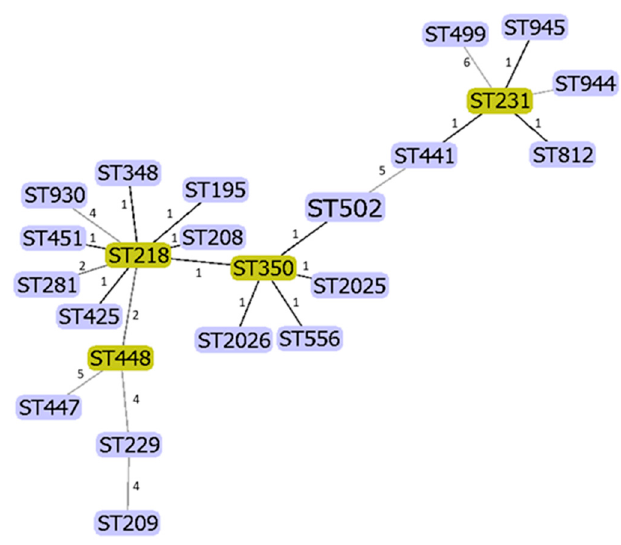
Figure 2. Dendrogram of detected MLSTs in A. baumannii in Austria. Dendrogram was calculated using goeBURST full MST algorithm using PHYLOViZ software (https://phyloviz.readthedocs.io/en/latest/index.html (accessed on 16 February 2021). Numbers on the lines indicate the distance between the types. Table 1. Multilocus sequence typing (MLST) and sequence types (ST) of carbapenem-resistant A. baumannii isolates in Austria.